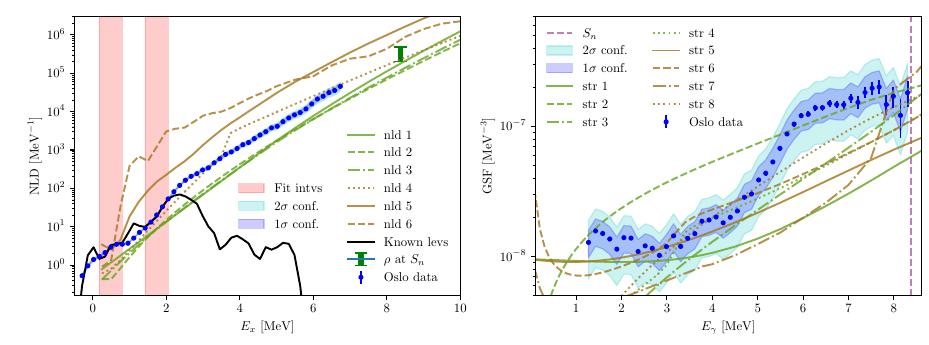
Figure 1. The NLD (left) and the GSF (right) for 127 Sb. nld and str indicate the model number obtained from TALYS 1.95 [15, 16]. The red bars in the left plot indicate the low excitation energy regions the NLD was normalized to (see Ref. [13] for details.)